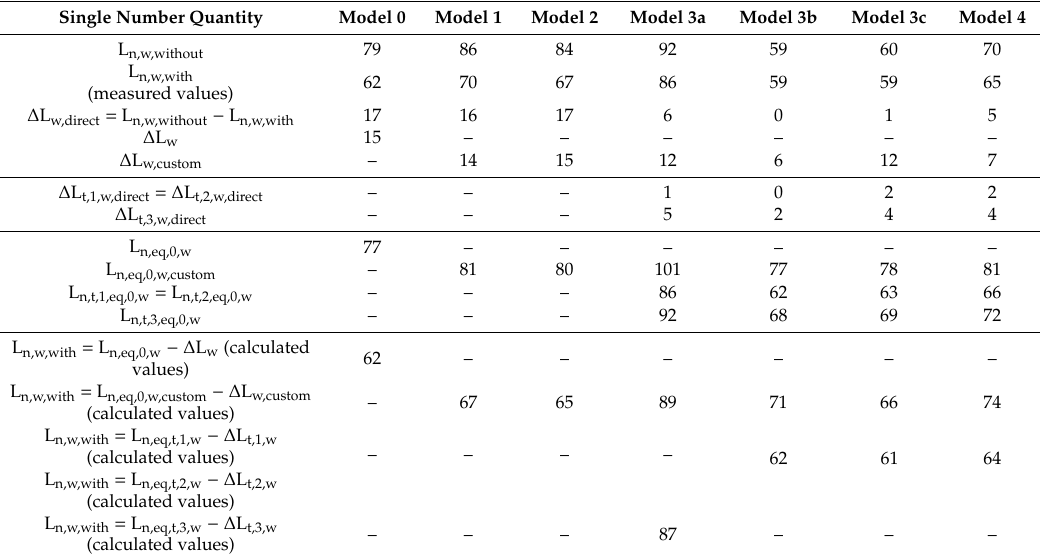
Table 2. Test results, single number quantities in